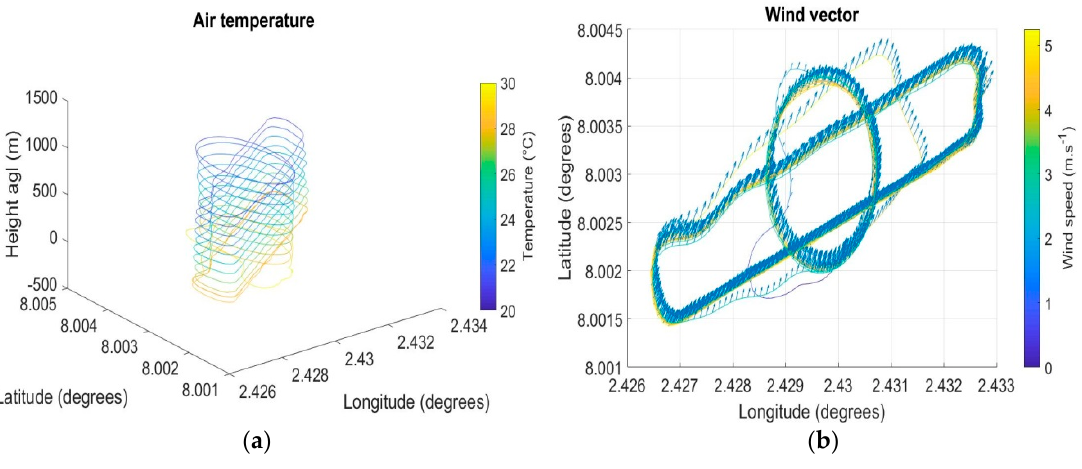
Figure 13. Air temperature ( a ) and wind vector ( b ) measured on July 15, 2016 at 16:45 (UTC).